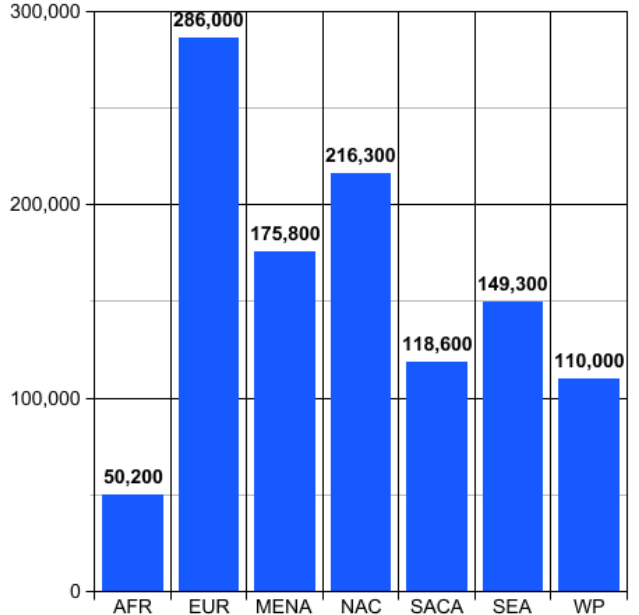
Figure 1. Estimated number of children and adolescents < 20 years with type 1 diabetes by IDFregion, 2017